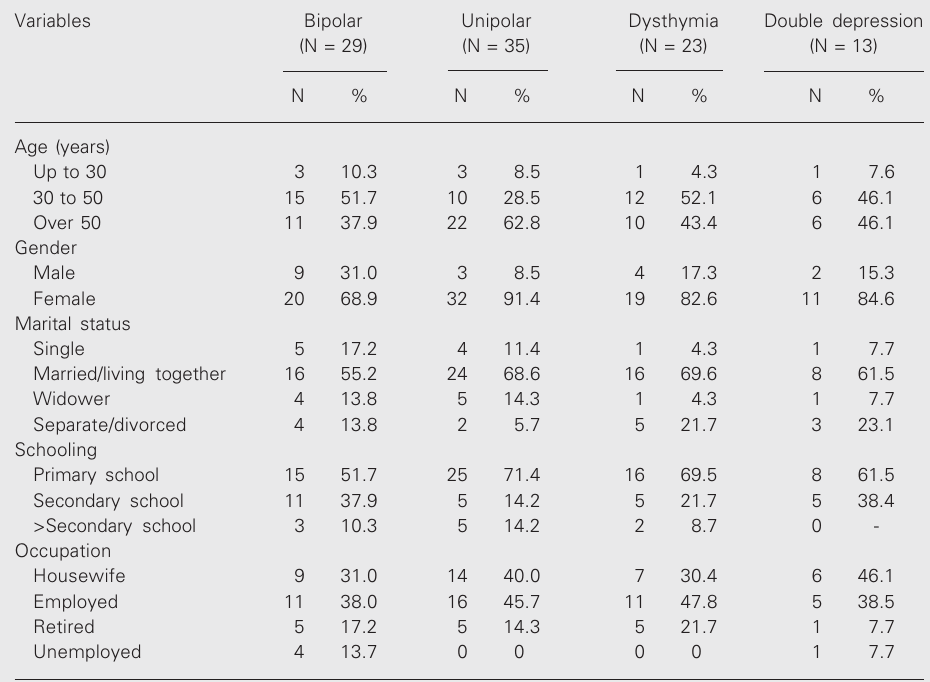
Table 1. Sociodemographic data of the mood disorder patients. Variables